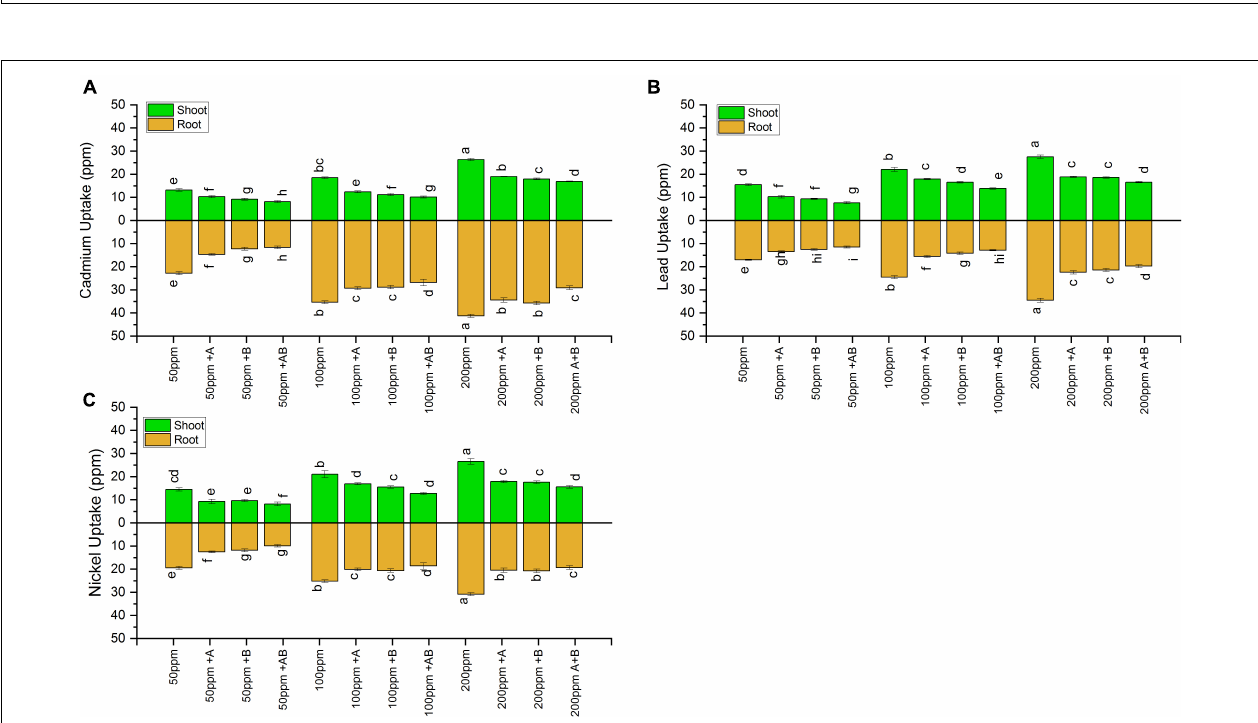
FIGURE 7 | Heavy metal (A) cadmium, (B) lead, and (C) nickel uptake by shoots and roots of wheat ( Triticum aestivum L.) grown under different concentrations of multi-HMs. Values are the mean of three replicates. Bars represent the standard error of means. Different letters above the bars indicate statistically significant difference between treatments at P ≤ 0.05. Details of treatments are the same as those in Figure 1 .